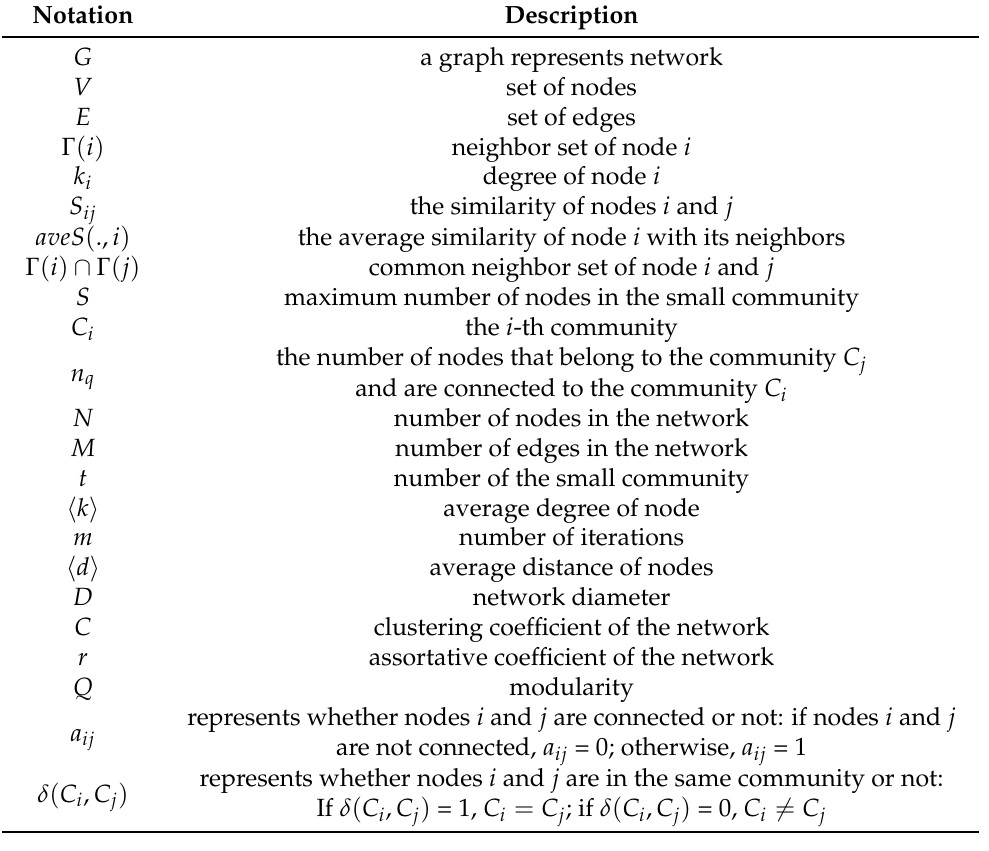
Table 2. Symbols and variables used